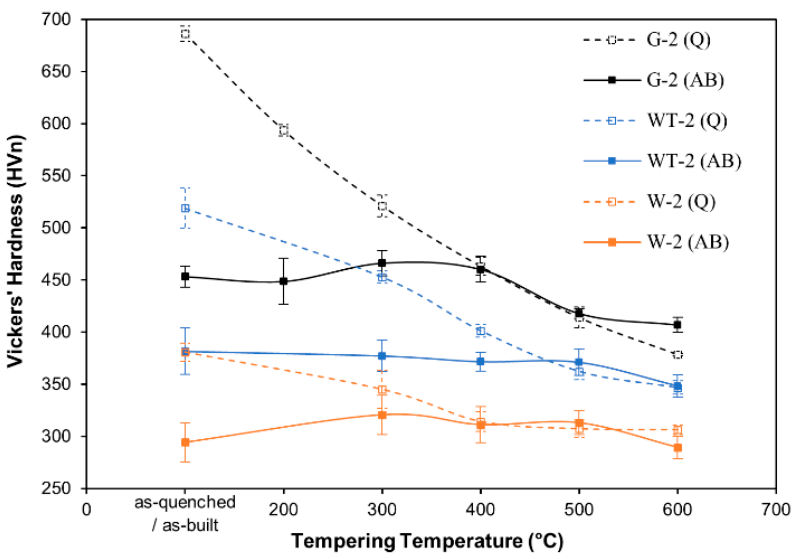
Figure 9. Tempering behaviour of W-2, WT-2 and G-2 alloys from as-quenched (Q) and as-built (AB) conditions.